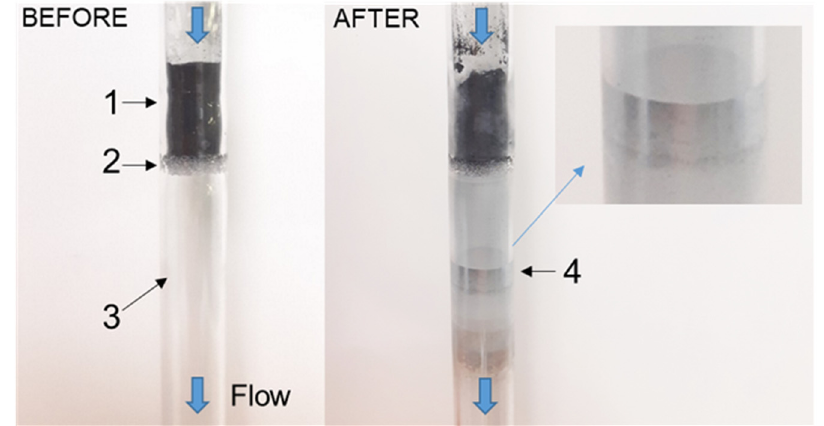
Figure 8. Reference sample before and after microwave treatment. (1) sample, (2) quartz frit to support the sample, (3) quartz holder, (4) volatilized zinc from the sample deposited on the quartz holder walls after treatment.